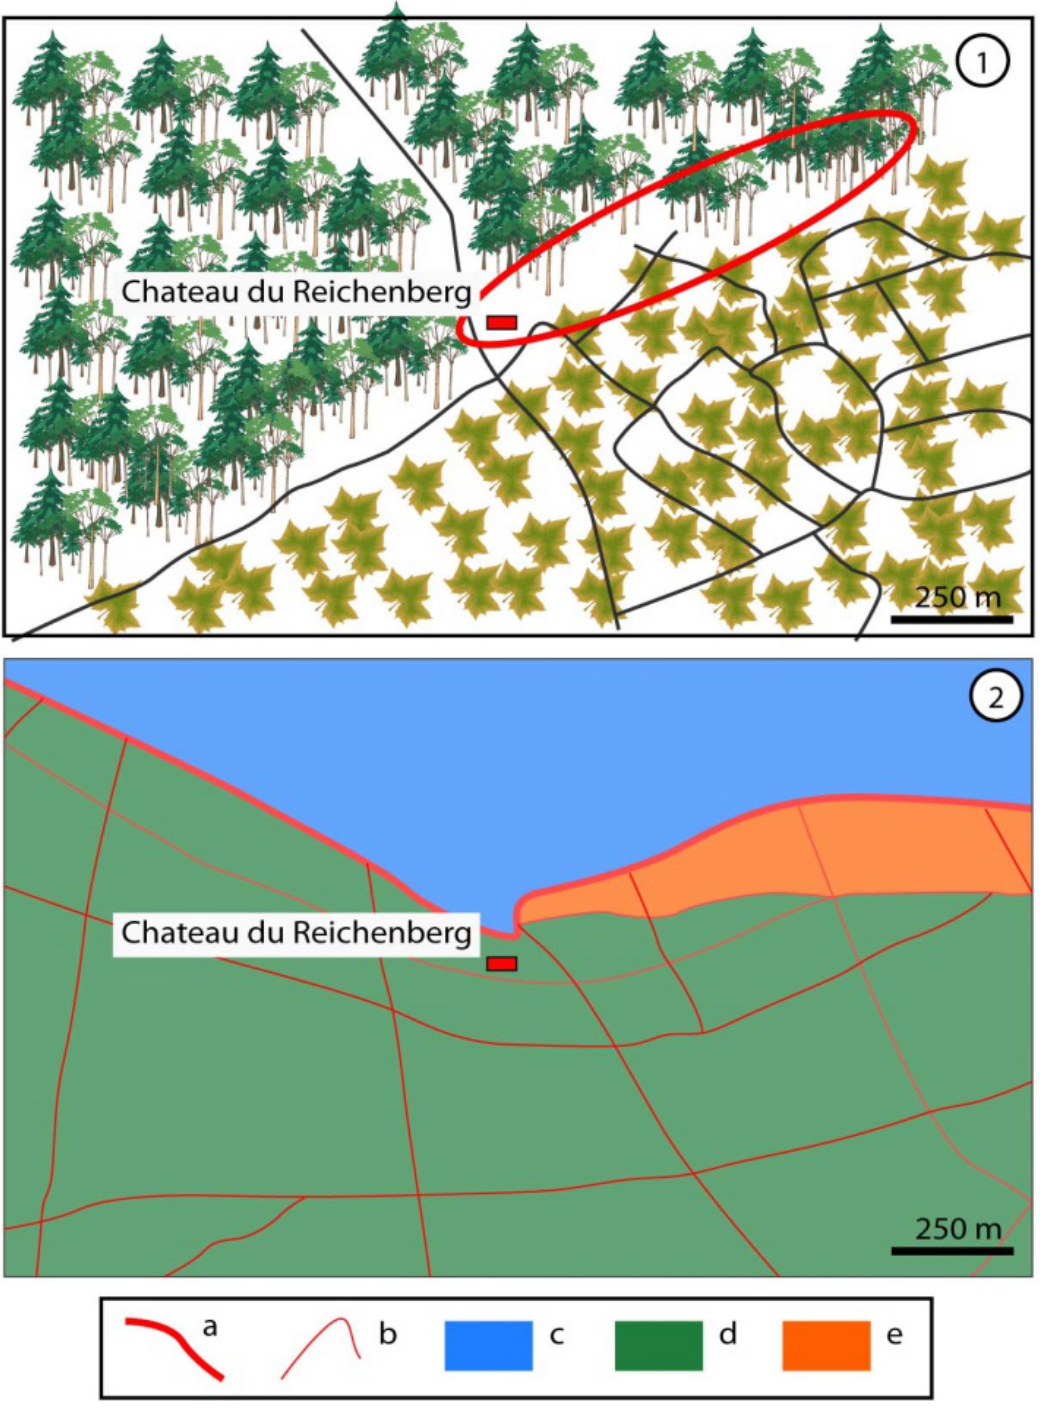
Figure 8. Sketch of the silicified limestone outcrops indicated with a red ellipse (view 1. The schema (view 2) indicates the a) Vosges fault line, b) faults in the fracture field, c) the Palaeozoic massif consisting mainly of granites and a Carboniferous sedimentary cover, d) the fracture field dominated by limestones, marls and Mesozoic sandstones, e: the principal silicification zone surrounding the limestones of the Upper Muschelkalk (Indian beads Limestone facies) (CAD Fl. Jodry from Ph. Duringer,